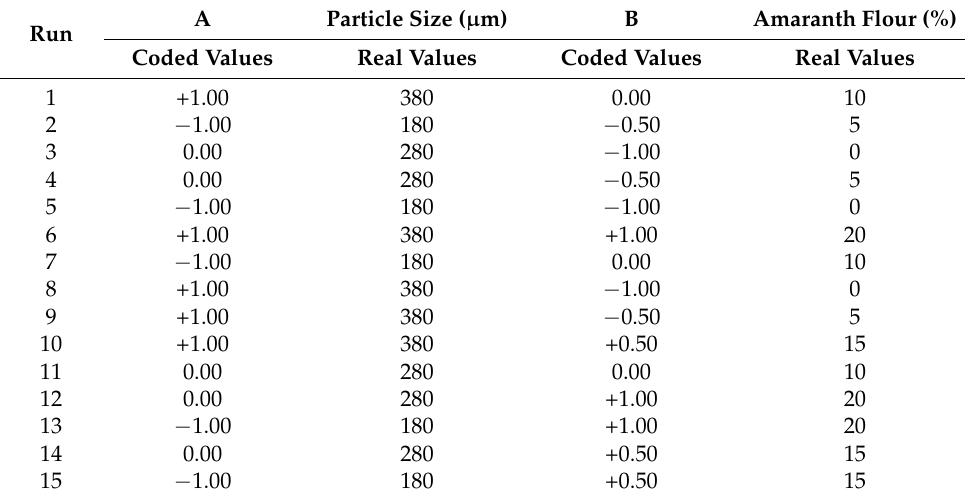
Table 1. Factors and their levels in the experimental